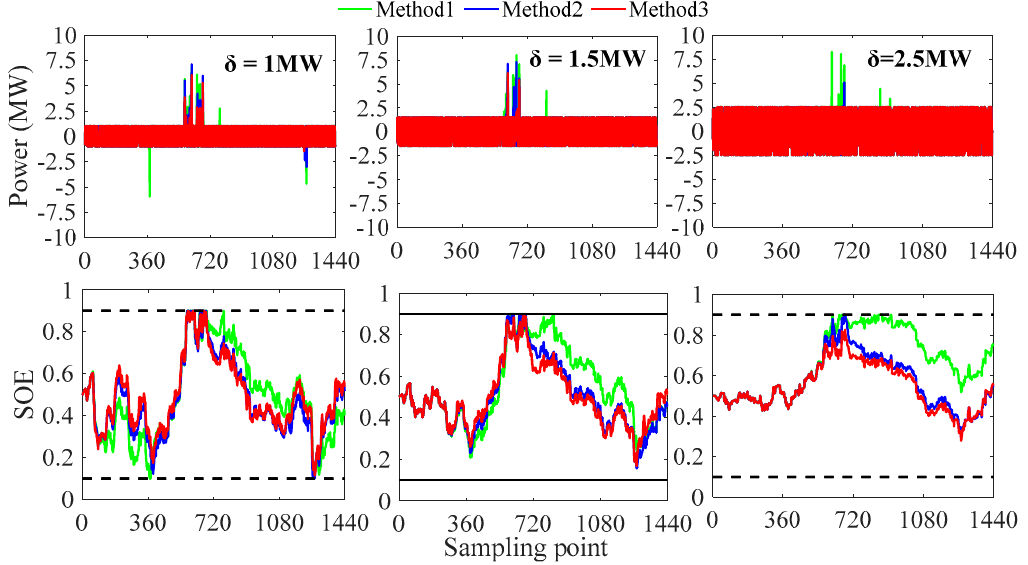
Figure 8. Comparison curve of Δ P G and SOE with three methods under different Q.